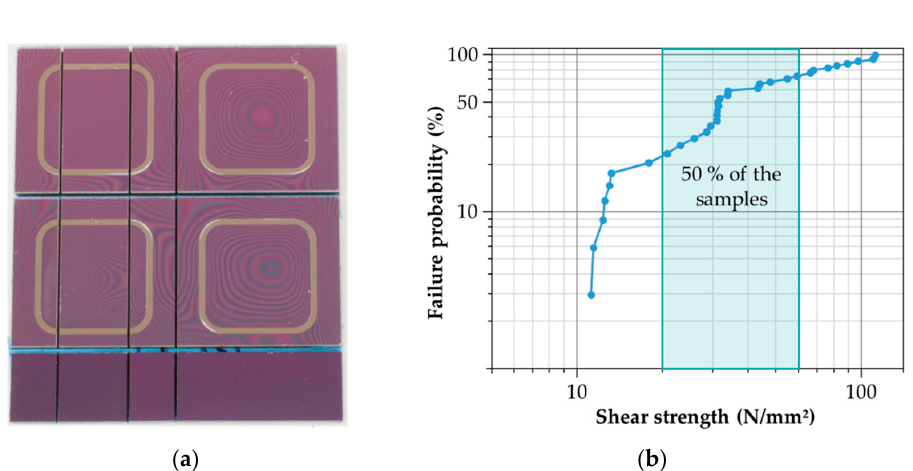
Figure 24. Characterization of mechanical strength: ( a ) Silicon-glass chip stack after dicing; ( b ) Shear strength of silicon-glass chip stacks bonded at I 0 = 78.6 A, f 0 = 1.898 MHz, t b = 130 s, and p = 3 MPa.